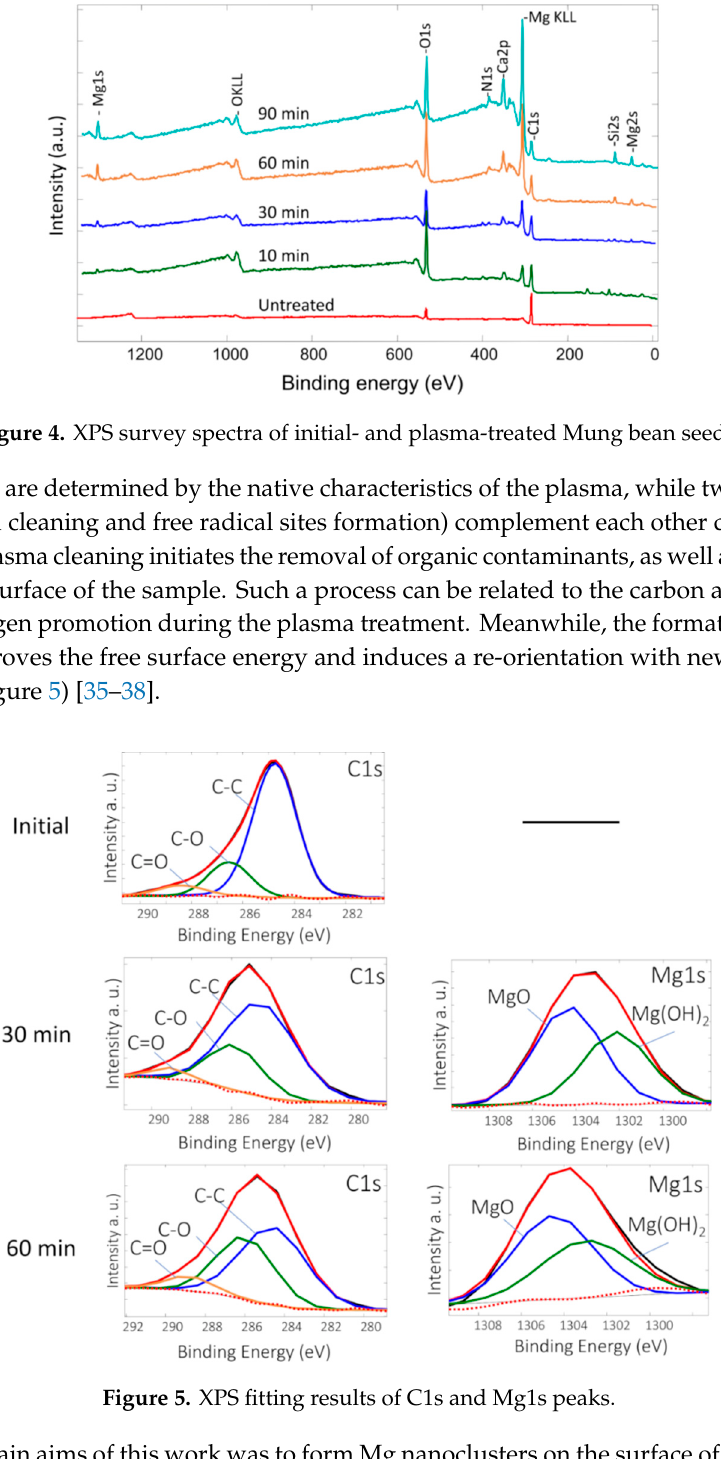
Figure 5. XPS fitting results of C1s and Mg1s peaks.